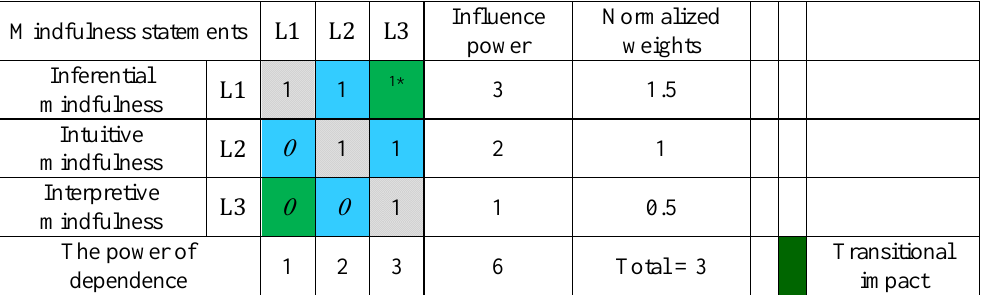
Table 11. Achieving the weights of auditors' level of consciousness Mindfulness